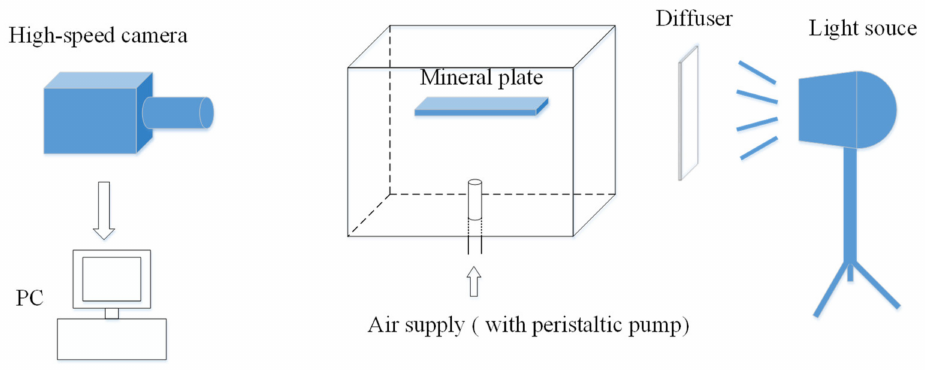
Figure 2. Schematic diagram of the experimental apparatus for observing the collision-rebound process between bubbles and